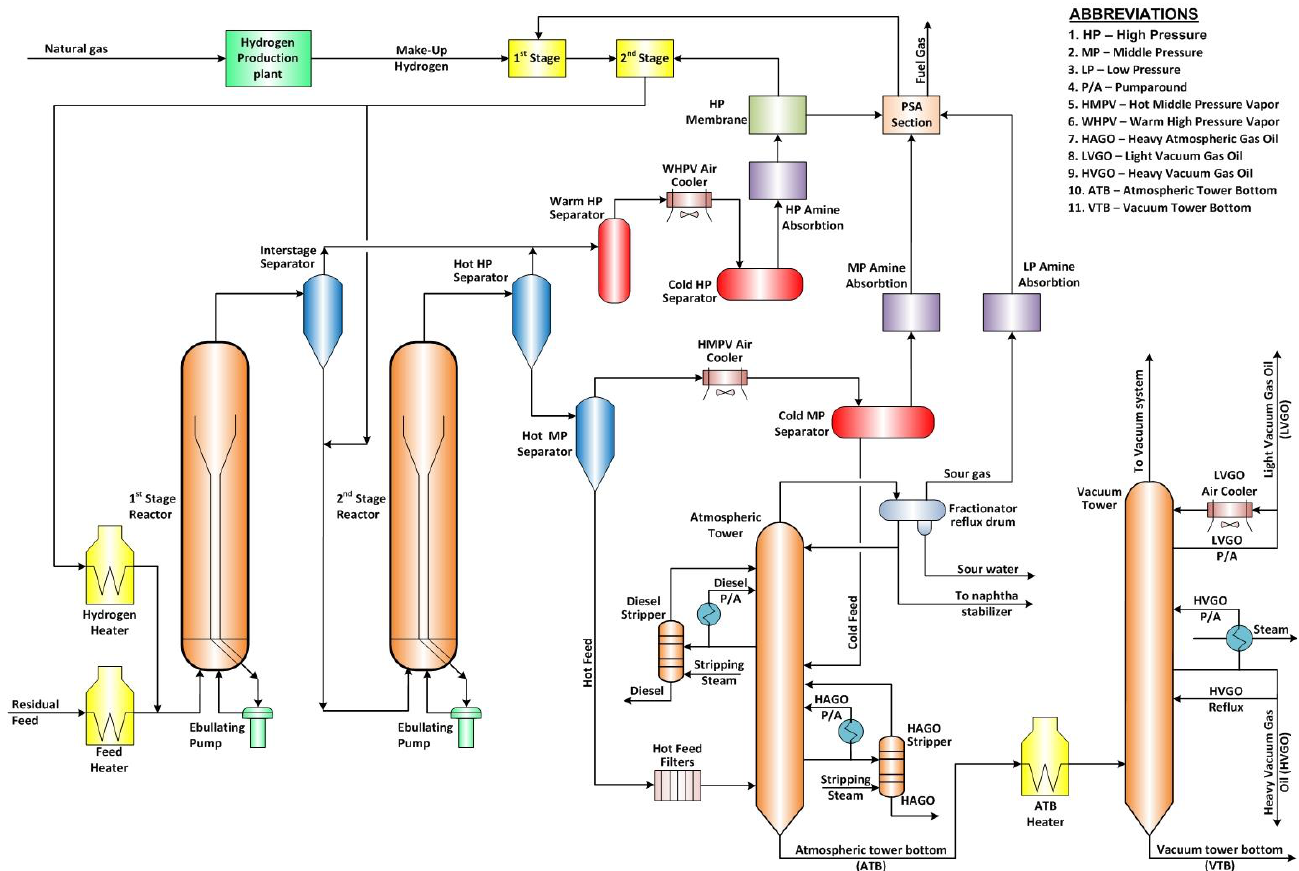
Figure 3. Process flow diagram of the commercial ebullated bed residue hydrocracker under study. During the study the cascade catalyst system to add fresh catalyst was replaced by a parallel one as shown in Figure 4.